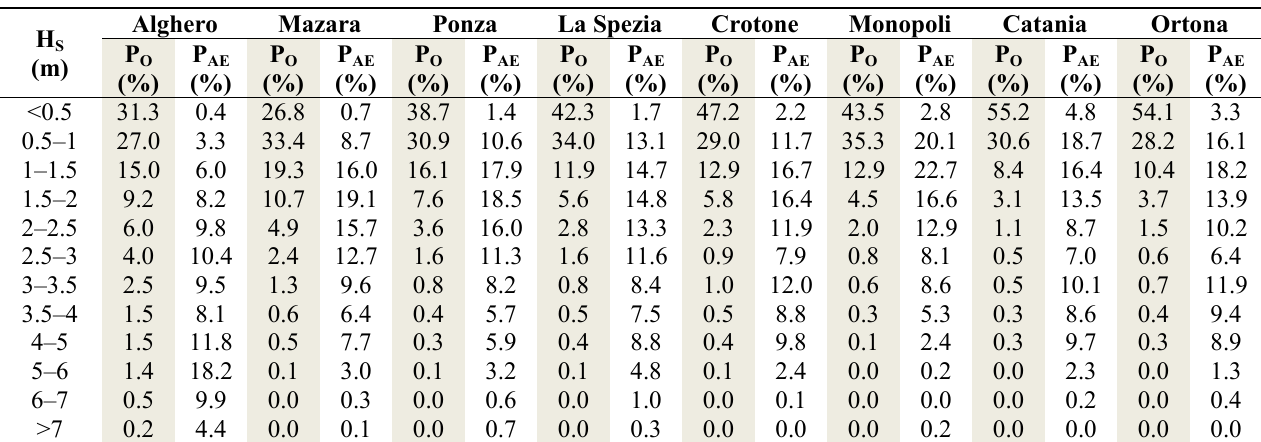
Table 2. Percentage of occurrence (P on white columns) corresponding to different wave height intervals. (P AE